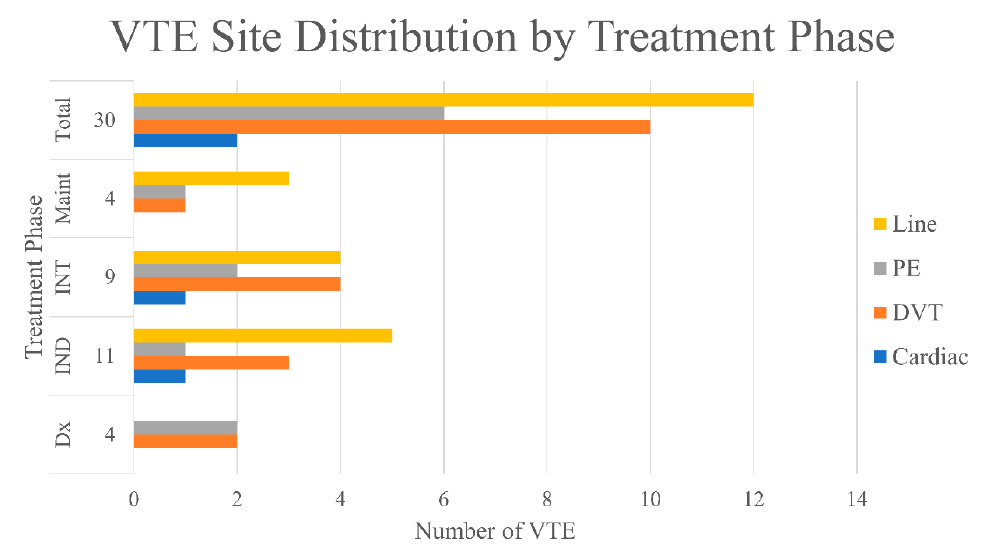
Figure 3. VTE site distribution throughout treatment phase. Dx = diagnosis; IND = induction; INT = intensification; Maint = maintenance.